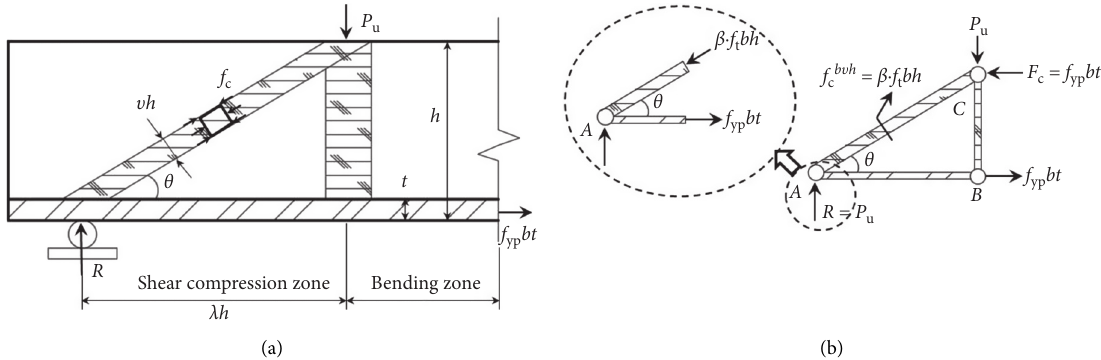
Figure 20: Tie-arch model: (a) stress analysis of Half-SC slab; (b) computing model.